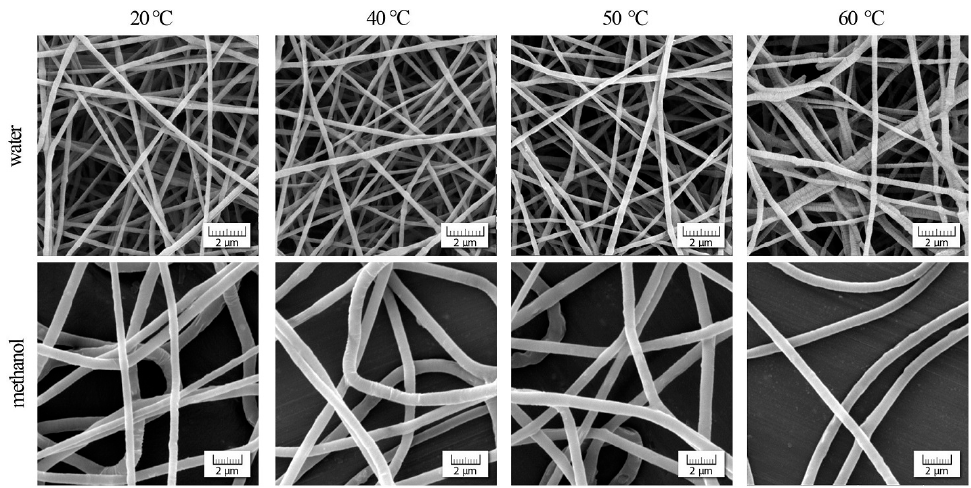
Figure 1. Effect of temperature on morphology of fibers obtained from PEO solutions.